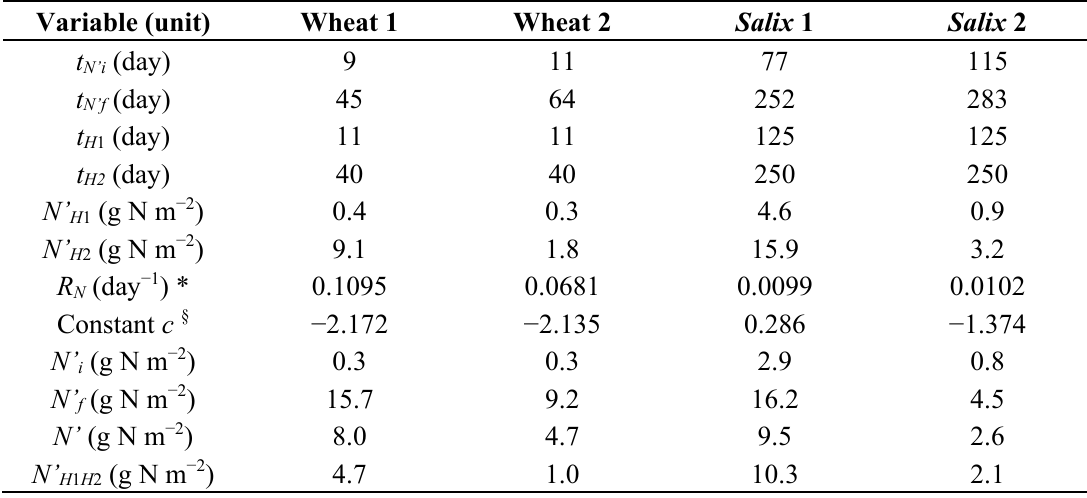
* The R N values represent the slopes of the lines connecting the plant N pools in Figure 1; § cf. Equation (6). In some of the scenarios, the accurate N’ values calculated with the extrapolation procedure ( i.e. , N’ in Table 1) differ greatly from the corresponding values calculated on basis of the original harvest dates ( i.e. , N’ H 1 H 2 in Table 1). For example in the wheat scenarios, the R N is much greater